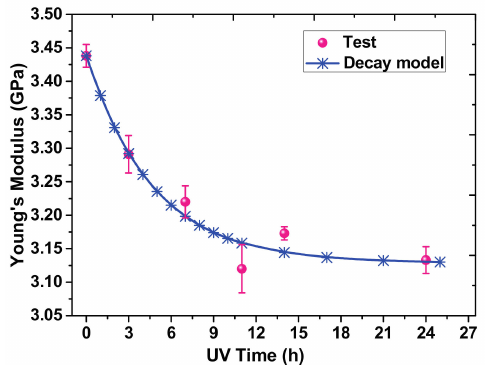
Figure 5. The Young’s modulus of PI films at different UV irradiation